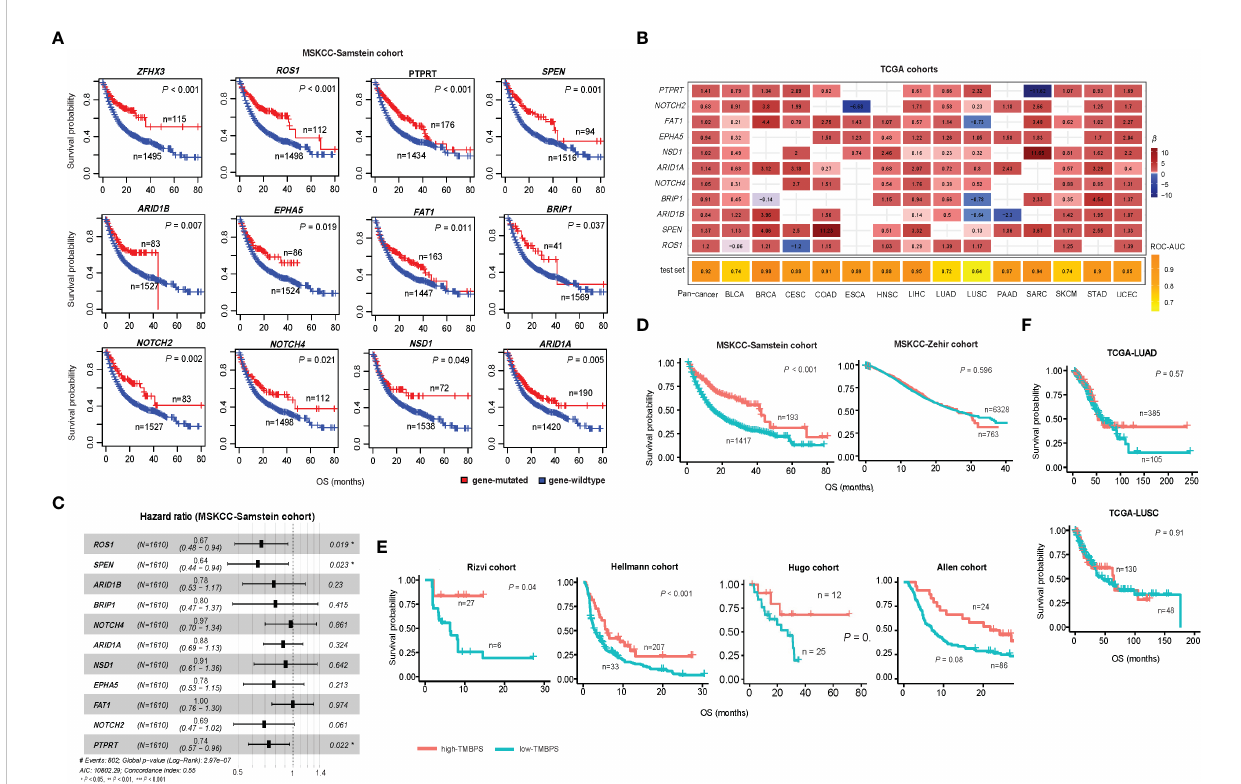
FIGURE 3 Correlations of gene mutations with survival prognosis in cancer. (A) Kaplan-Meier curves showing 12 genes whose mutations correlate with better overall survival (OS) in the MSKCC-Samstein cohort receiving the immune checkpoint blockade (ICB) therapy. The 12 genes also signi fi cantly correlate their mutations with increased TMB in at least 10 TCGA cancer types. (B) Predictions of high- versus low-TMB in TCGA pan-cancer and in 14 individual cancer types based on the mutation status of 11 genes using logistic regression models with the variables selected by the Lasso. The b - values for each variable in the logistic regression models and the ROC-AUC indicate the prediction performance. (C) Correlations between mutations of 11 genes and OS in the MSKCC-Samstein cohort by the Cox proportional hazards model. (D) Kaplan-Meier curves showing that the TMB prognostic score (TMBPS) correlates positively with OS in the MSKCC-Samstein cohort receiving the ICB therapy, while it shows no signi fi cant correlation with OS in the MSKCC-Zehir cohort without the ICB therapy. (E) Kaplan-Meier curves show that the TMBPS correlates positively with OS in two lung cancer cohorts (Rizvi and Hellmann cohorts) and two melanoma cohorts (Allen and Hugo cohort) receiving the ICB therapy. (F) In contrast, it shows no signi fi cant correlation with OS in the TCGA lung cancers not receiving the ICB therapy. The log-rank test P -values are shown in the survival